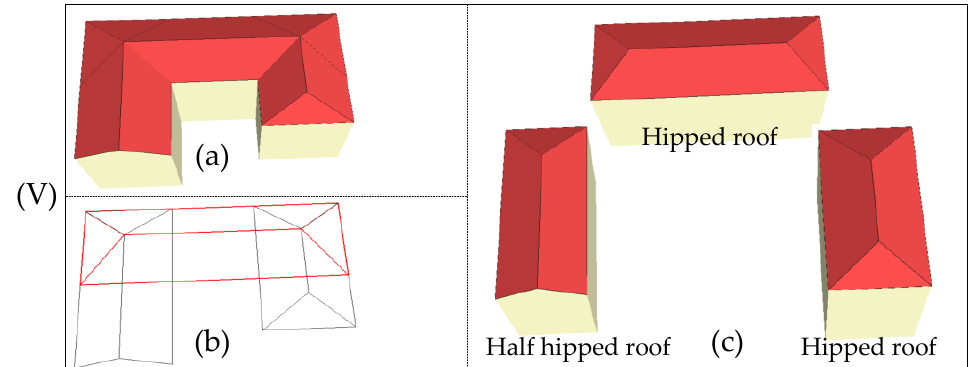
Figure 8. Experimental results of some representative complex buildings. ( a ) The decomposition and reconstruction 3D models, ( b ) the 3D geometric vector boundary, and ( c ) the generated building subparts.